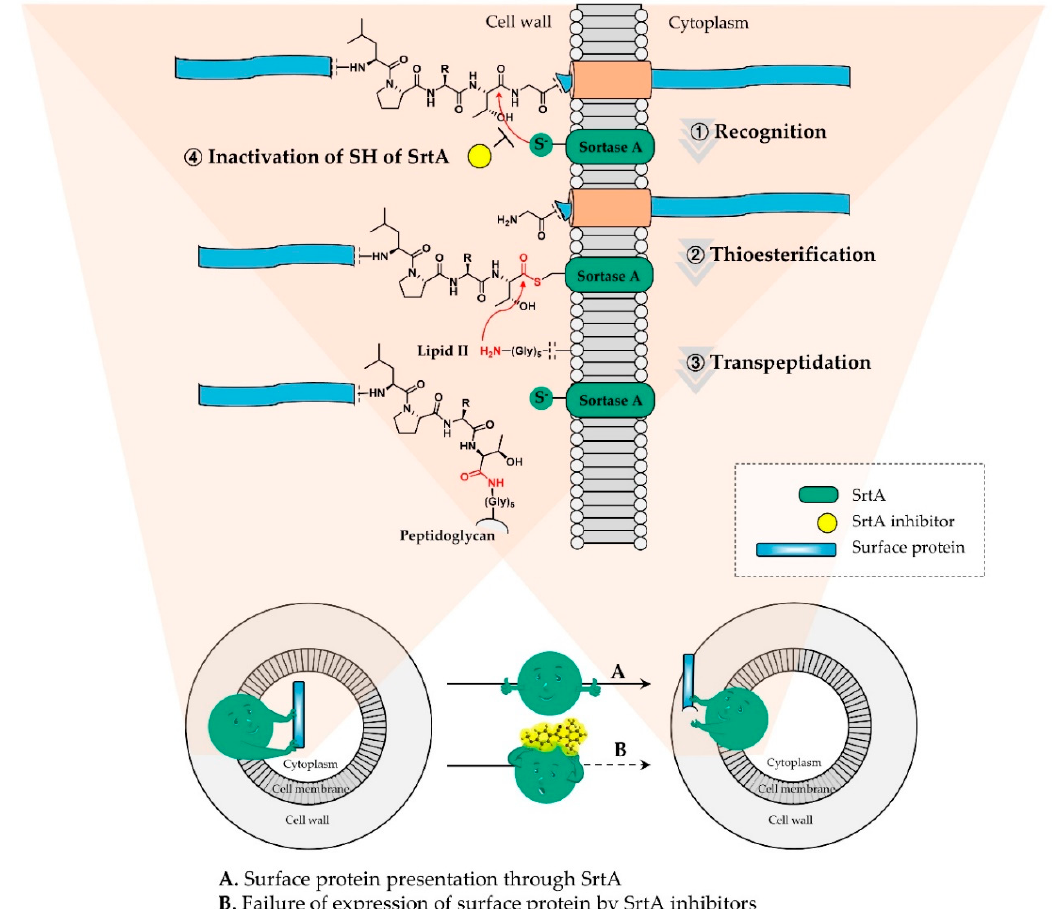
Figure 1. Mode of action of SrtA and its inactivation through its inhibitor; the surface proteins are covalently attached to the cell wall peptidoglycan with the aid of SrtA via the following sequential steps: (1) recognition, (2) thioesterification, and (3) transpeptidation. Further, they are inhibited for display, resulting in failure of adhesion to specific organ tissues, invasion of host cells, or the evasion of host-immune responses (4).